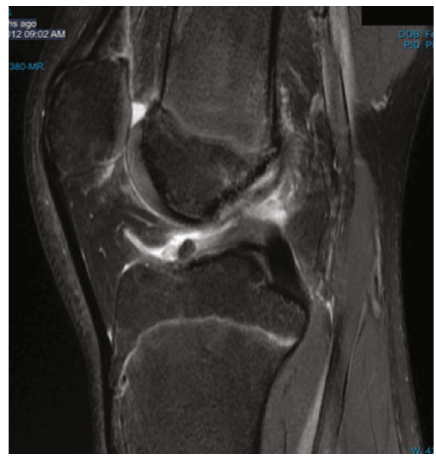
Figure 1: MRI demonstrating initial ACL rupture in